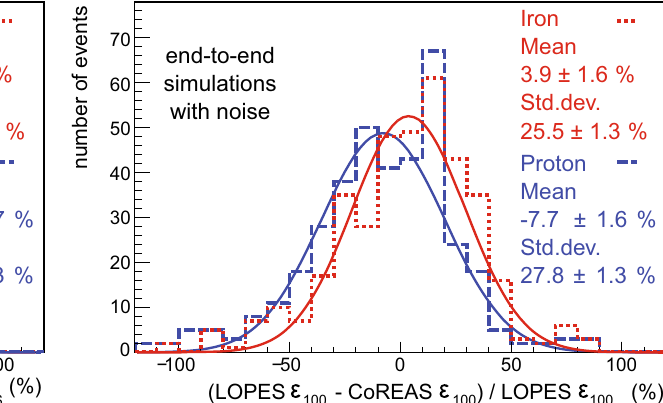
Fig. 10 Event-by-event comparison of the cross-correlation-beam amplitude of the LOPES measurements and the end-to-end CoREAS proton and iron simulations (including noise; for east-west antennas). The k values are the offsets of the fitted dashed lines to the one-to-one